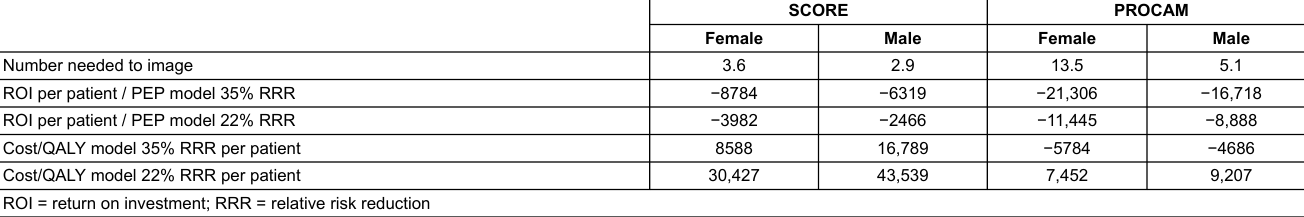
Table 6: a: Cost-efficiency analysis in CHF based on the personalised price (PEP) and cost per quality adjusted life-year (QALY) models.